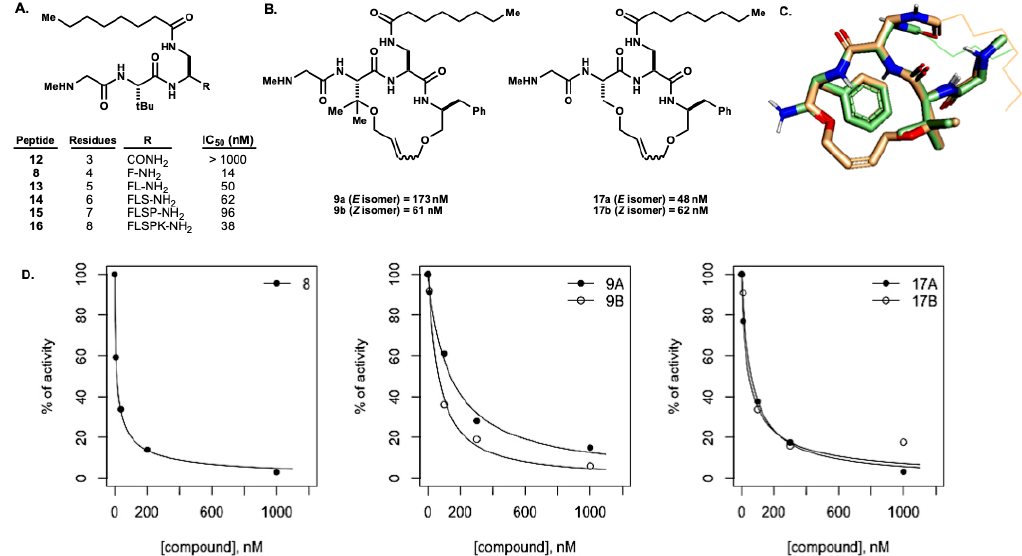
Figure 2. ( A ) Ghrelin truncation peptide series and respective IC 50 values. Enzyme activity was quantified using the method described by Yang et al. [18] (see Materials and Methods); ( B ) Macrocycles derived from the parent peptides and respective IC 50 values; ( C ) Structural overlay of 9b (orange) against 8 (green), octanamide chains are indicated as line bonds for clarity; ( D ) In vitro inhibition of proghrelin octanoylation mediated by GOAT using the shown compounds. The experimental data were fit to a 4-parameter logistic model, (Bottom − Top)/(1 + (I/IC 50 ) n ) + Top [24] using DYNAFIT software [25]. The Top was defined as reaction conditions without inhibitor and the Bottom was defined as reaction conditions with full inhibition by 5 µM concentration of 2 . Top and Bottom conditions were included in every experiment.